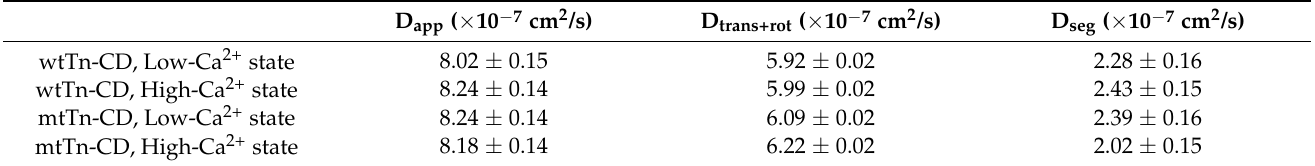
Figure 3. Summary of Q 2 -dependence of the Γ values of ( a ) the wtTn-CD and ( b ) the mtTn-CD, and summary of the diffusion coefficients, ( c ) D app , ( d ) D trans+rot , and ( e ) D seg , obtained from linear fits to the plots in ( a , b ). Error bars within the symbols are not shown. Table 2. Summary of the diffusion coefficients of the